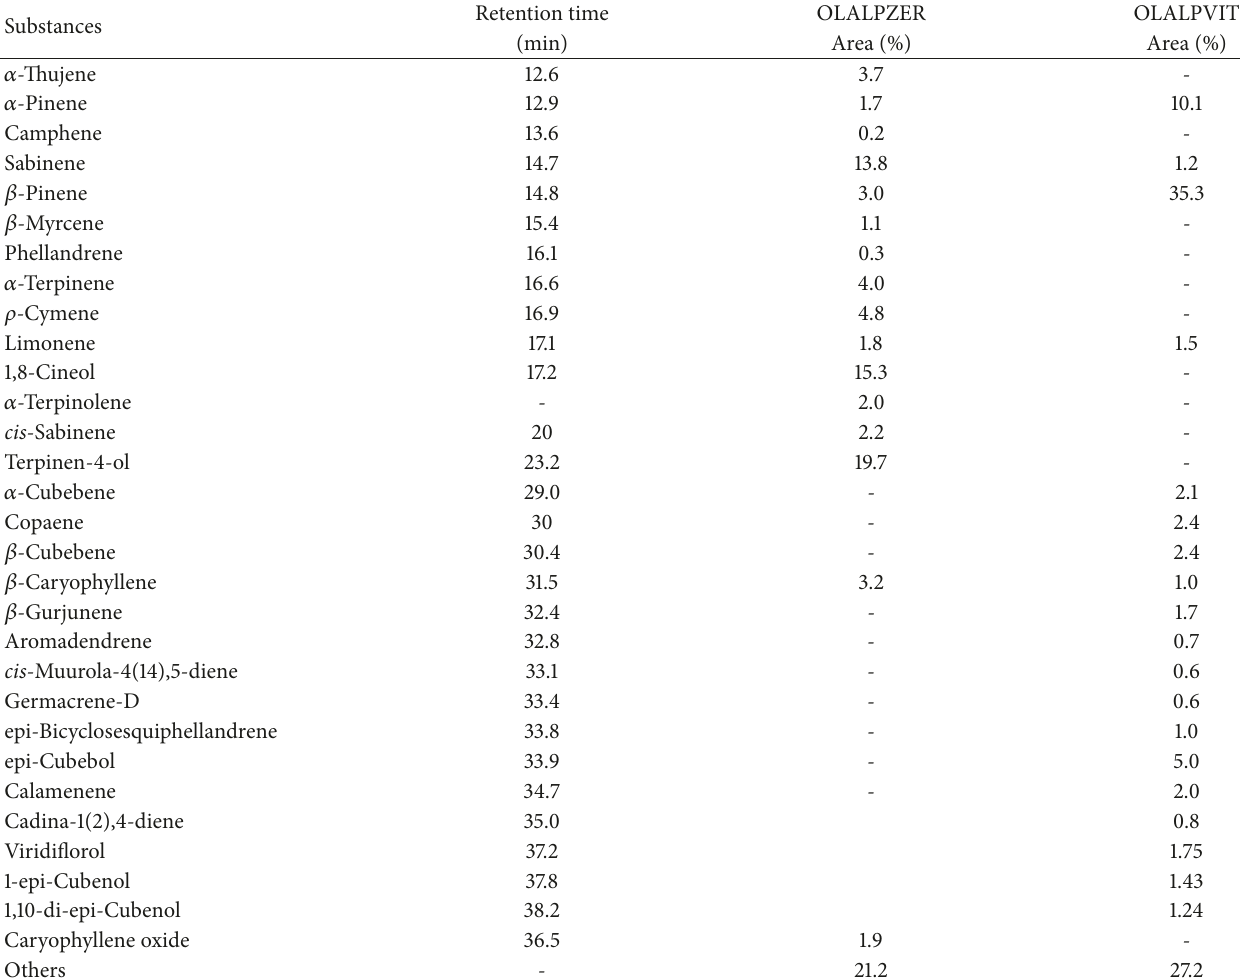
Table 1: Chemical composition of the essential oils extracted of from fresh leaves of A. zerumbet (OLALPZER) and A. vittata (OLALPVIT) determined by GC-MS